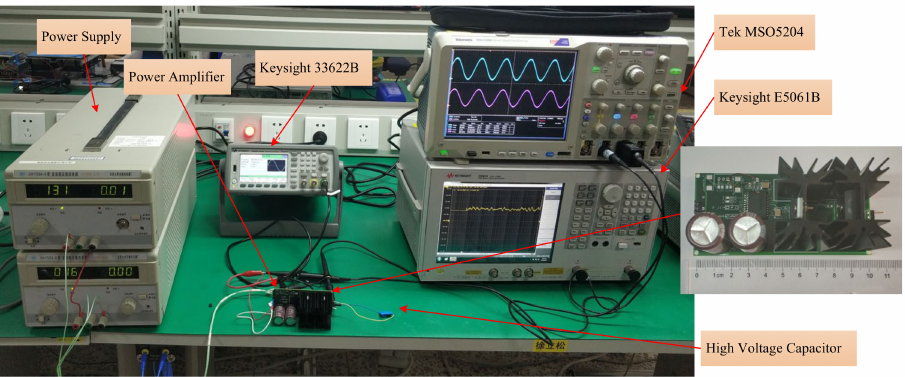
Figure 14. The tests for the power amplifier using high-voltage operational